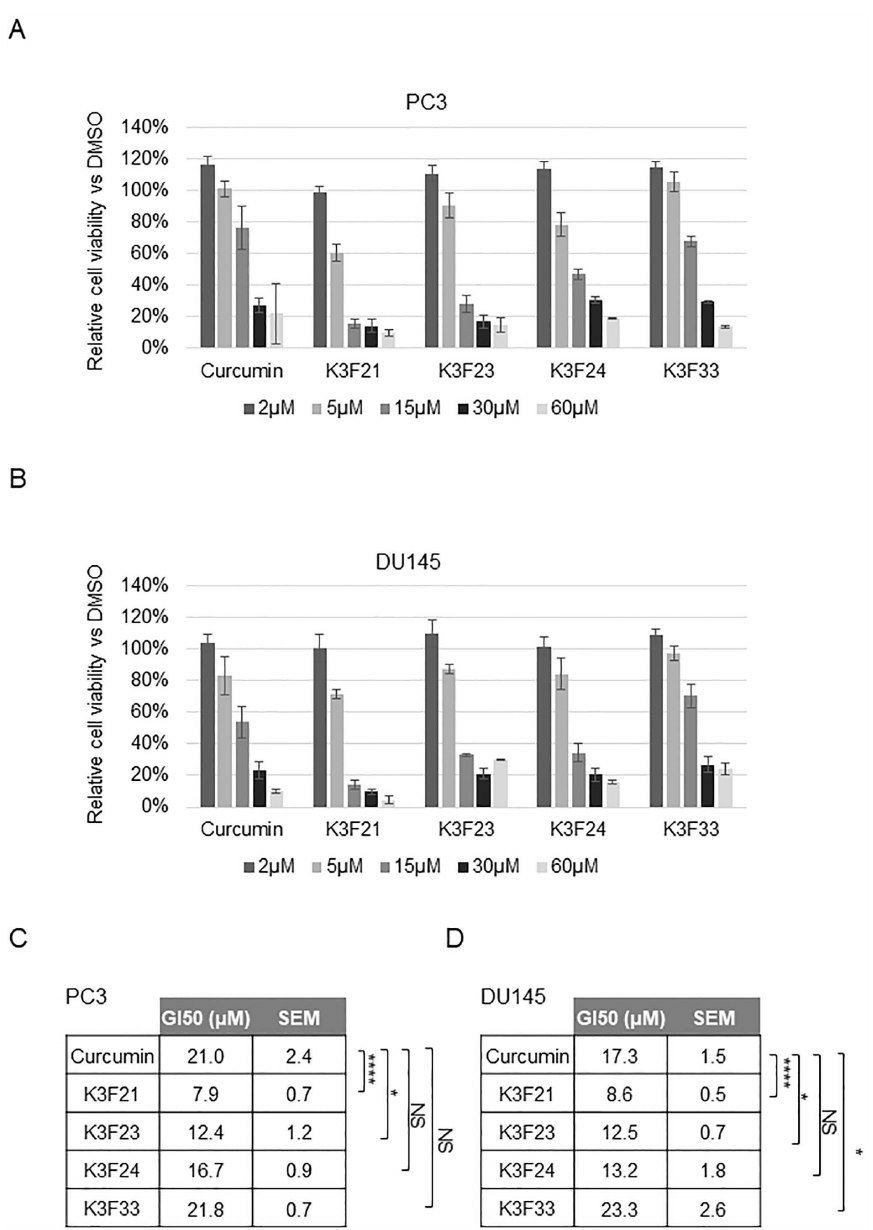
Figure 3. Dose-dependent effect of K3F-derivatives on PCa cells. Cell growth of PC3 ( A ) and DU145 ( B ) prostate cancer cells was assessed by MTT assays following 48 h treatment with the indicated molecules. Data are presented as relative cell viability (%) of treated cells versus DMSO control cells, arbitrarily set at 100%. The bars represent the mean of four independent experiments ± SEM. GI50 values, SEM and statistical significance compared to curcumin have been indicated for PC3 ( C ) and DU145 ( D ). p values * < 0.05, **** < 0.0001, NS = not